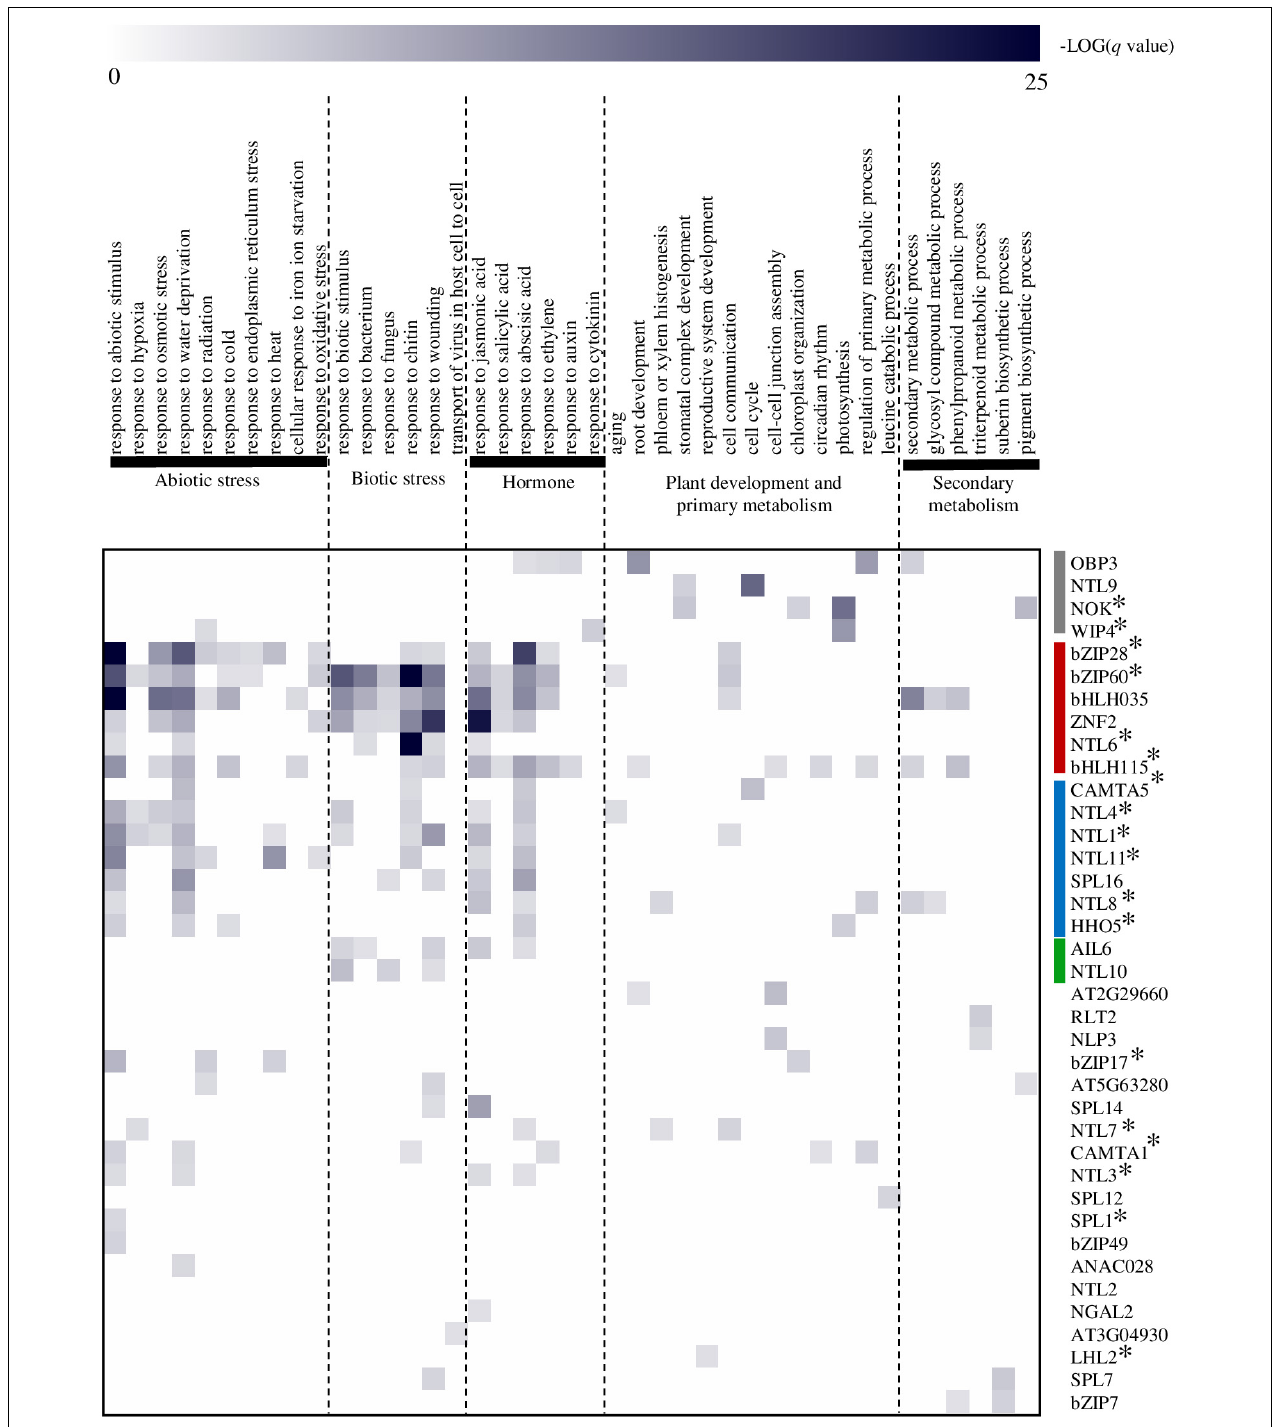
FIGURE 4 | Prediction of atMB-TF functions by means of a regulatory network-based approach. Functional terms were obtained per TF by Gene Ontology (GO) Biological Process (BP) enrichment analysis of their respective target genes (De Clercq et al., 2021). MB-TFs were hierarchically clustered (average linkage) based on their functional categories using Genesis software version 1.6 (Sturn et al., 2002). atMB-TFs that regulate a broad range of abiotic and biotic stress responses are in indicated in red; those involved mainly in responses to water deficit and ABA, in blue; mostly involved in biotic stress responses, in green; and those in specific cellular and/or developmental processes, in gray. A selection of GO-BP terms are displayed for the heatmap presentation. For the complete list of enriched GO-BP terms per atMB-TF, see Supplementary Table 3 . *Indicates atMB-TFs with correctly predicted function(s).